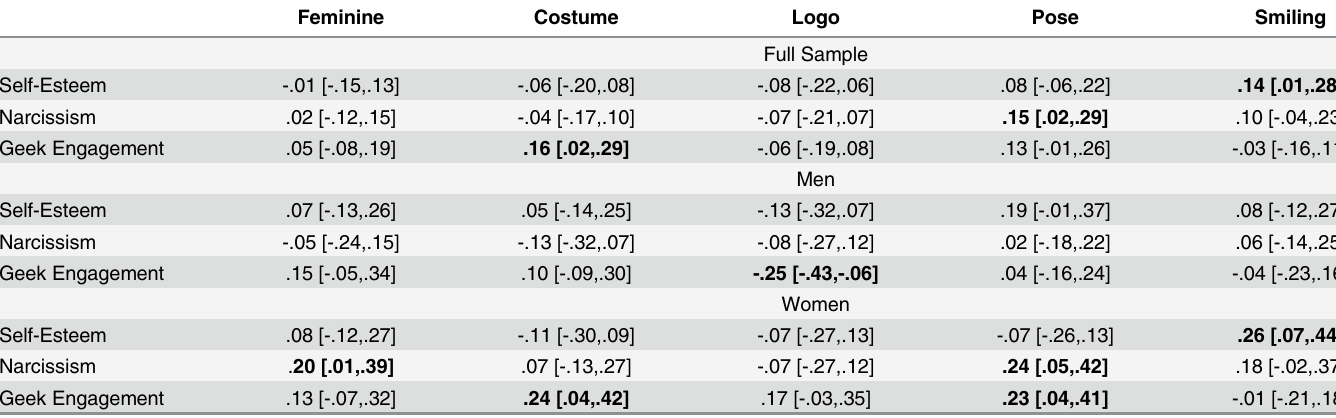
Table 4. Correlations between Appearance Ratings of Dragon * Con Photographs and Self-Esteem, Narcissism, and Geek Engagement. Feminine